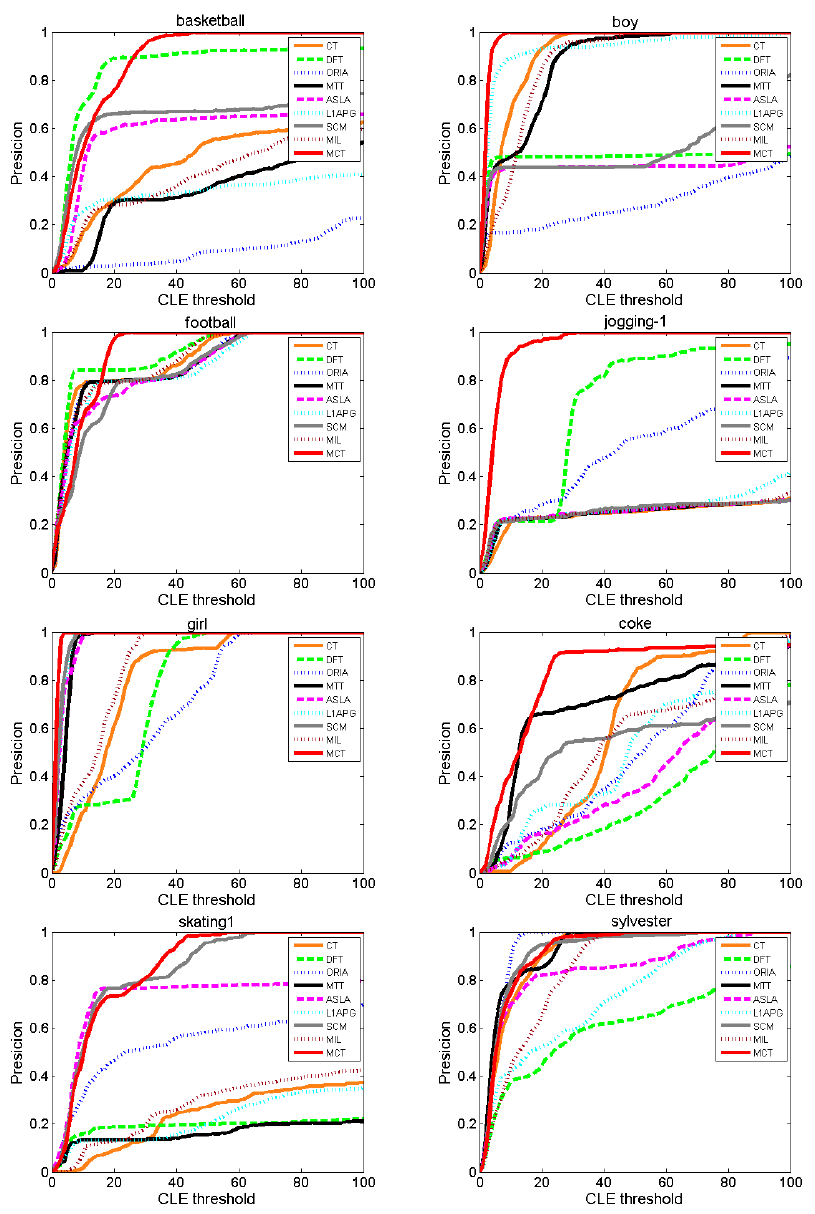
Figure 7. Precision comparison of the algorithms. Table 4. Average precision of the algorithms.